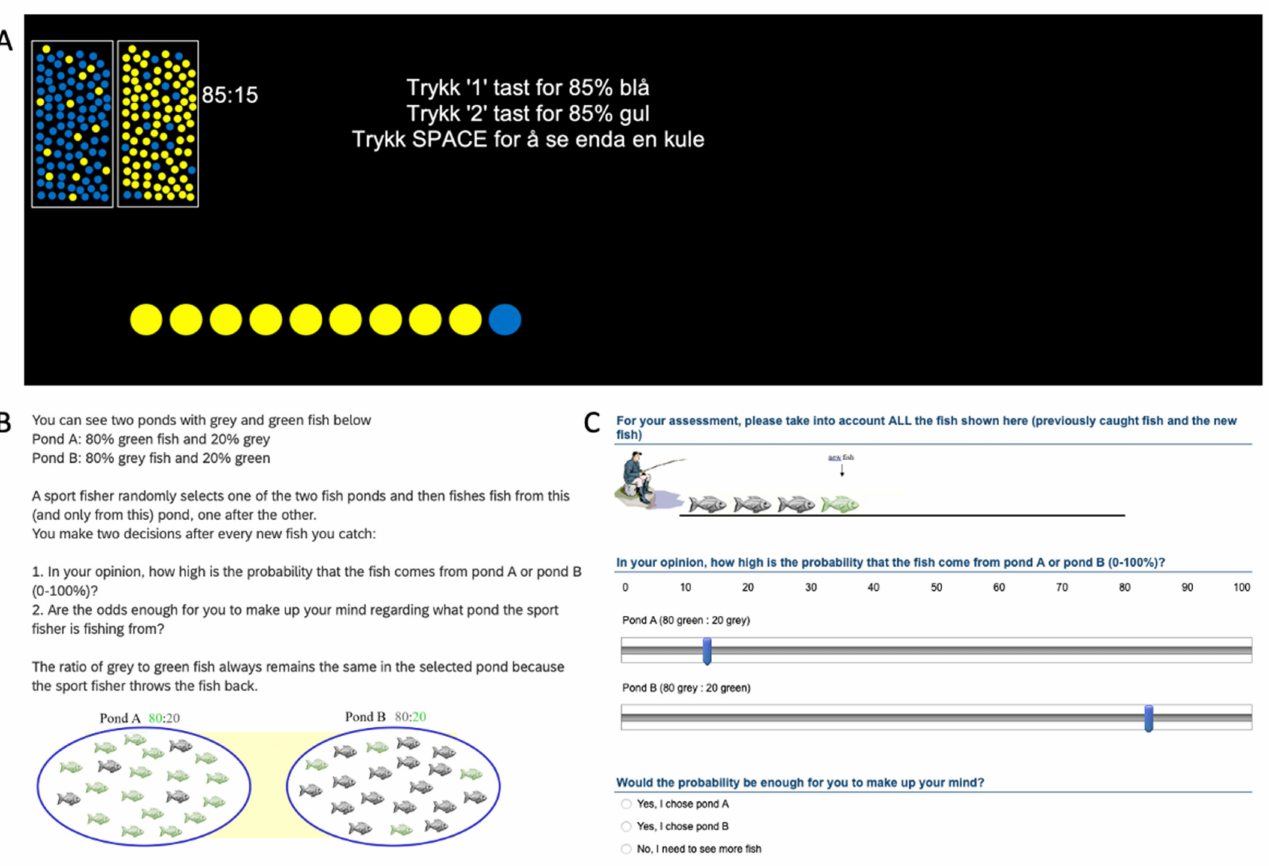
Figure 1. Overview of the two ‘beads task’ variants used. ( A ) Mid-trial for the abstract variant (administered in both Norwegian and English depending on the participant’s native language). Trykk 1/2 task for 85% blå/gul = press 1/2 for 85% blue/yellow, Trykk space for å se enda en kule = Press space to see another bead. Working memory demand was eliminated by providing the ratio of the two urns in the upper left corner. ( B ) Instruction page and pond presentation for the cover story variant. ( C ) Fourth trial in the cover story variant showing first the observation, then the probabilistic judgement, separate for both ponds and finally asking for a decision. Working memory demand was eliminated by providing the ratio of the pond in brackets. Note that the ratio information during a trial is visual in the abstract version but textual in the cover story